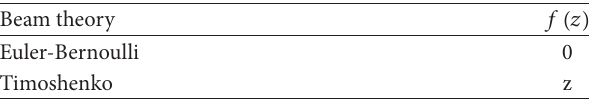
Table 1: The shape function for different beam theories. Beam